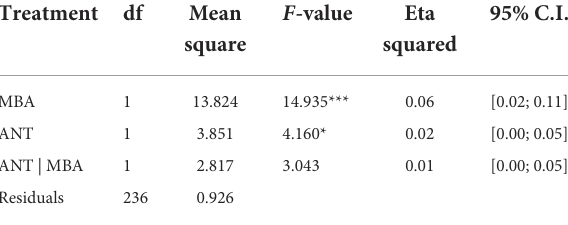
TABLE 8 Factorial ANOVA analysis of direct